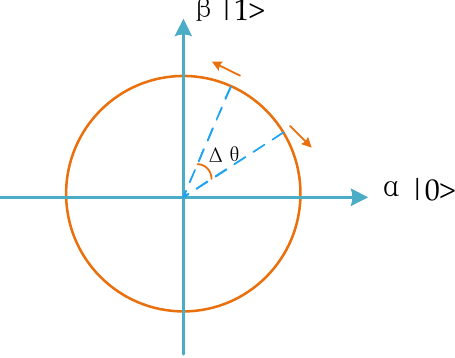
Figure 6. Scatter plot of the nodes of the full flow of the algorithm. Figure 6. Scaer plot of the nodes of the full flow of the algorithm. The coding and decoding process shows that each chromosome after decoding (pro- cessor serial number) corresponds to each chromosome before decoding (qubit matrix). A mutation operation on the decoded chromosome is equivalent to a mutation operation on the qubit matrix before decoding. Because of this correspondence, the quantum rotation gate [27] is introduced to mutate the gene bits (qubits) of the chromosome before decoding. In contrast to the randomness generated by the variation operation of the traditional genetic algorithm, the main function of the quantum rotation gate is to make the population mutate to the current optimal individual obtained. In this way, the optimal solution can be obtained and the speed of convergence increased. The rotation direction is shown in Figure 7.